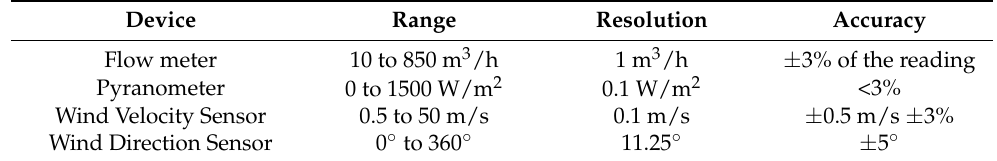
Table 1. Devices’ technical